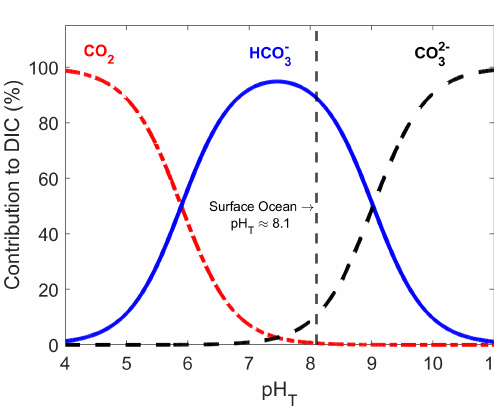
and CO 2 − to total dissolved inorganic carbon in seawater as a function of pH T 3 3